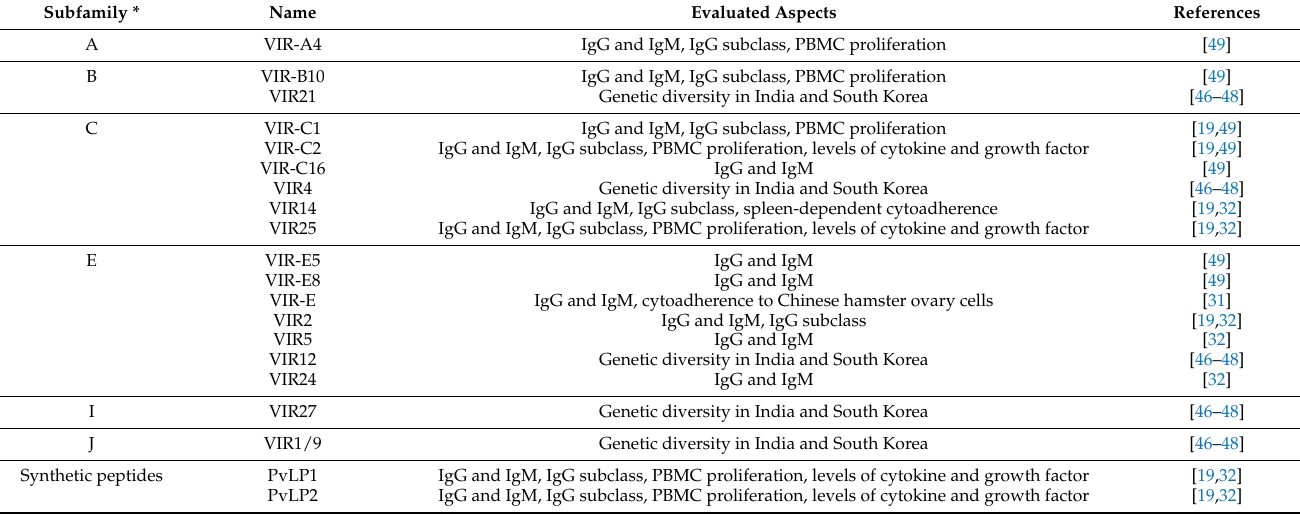
Table 2. VIR proteins and synthetic peptides studied